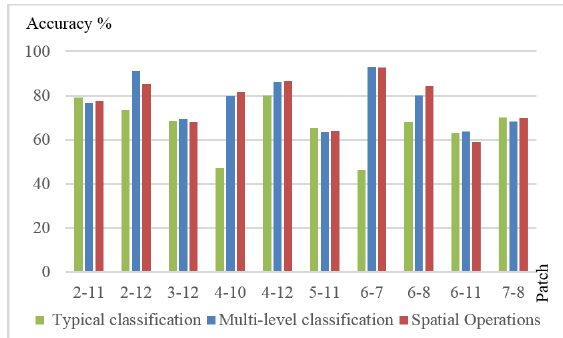
Figure 14. Impervious surface accuracy of the proposed method in test patches.